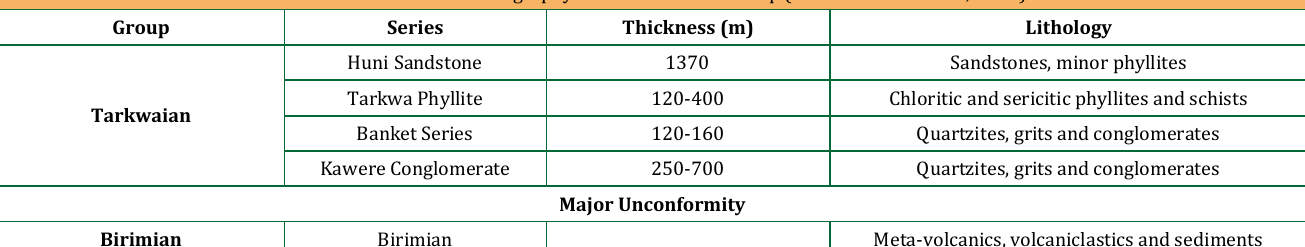
Table 1: Summarized stratigraphy of the Tarkwaian Group (Modified after Kesse, 1985)